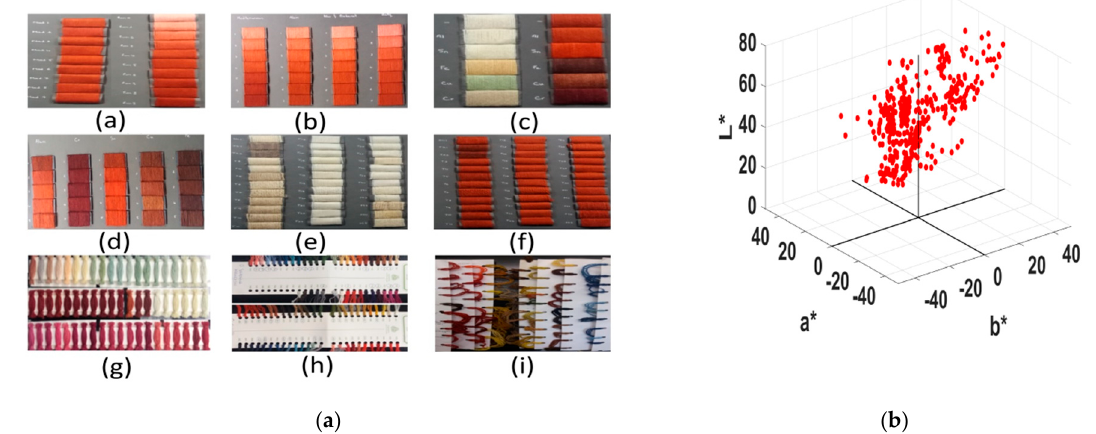
Figure 1. ( a ) Images of all samples used in this study; ( b ) colors of the samples in CIELAB space. Set-2: